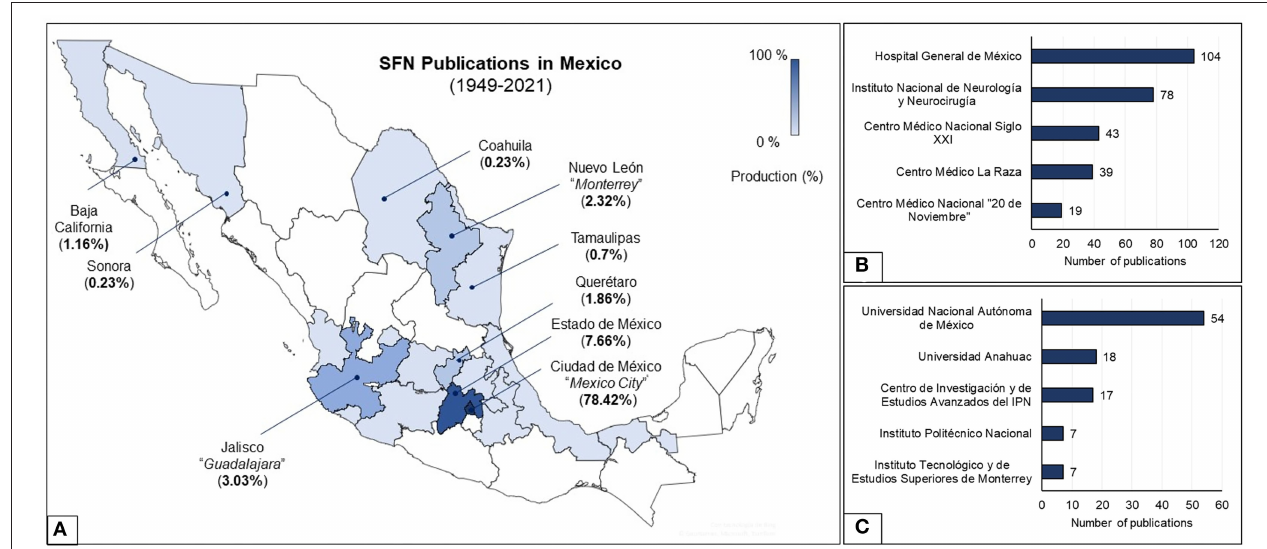
FIGURE 4 | (A) Scientific production map of Mexico. (B) Most productive neurosurgery departments. (C) Most productive universities and research centers.